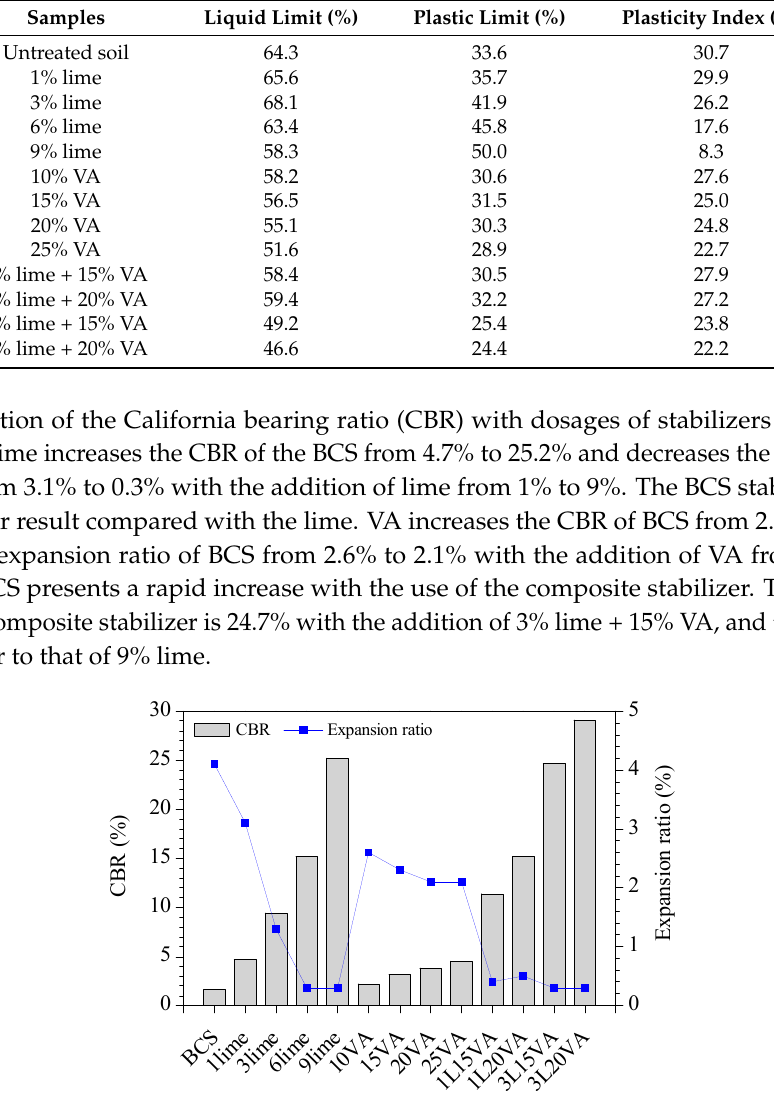
Figure 4. Influence of stabilizer content on the California bearing ratio (CBR) and expansion ratio of BCS.